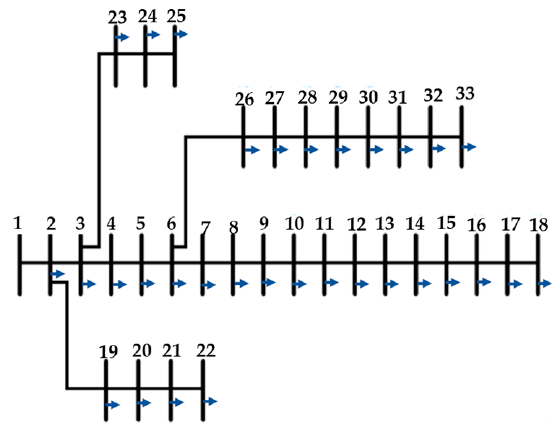
Figure 4. IEEE Standard 33 Bus Distribution System.